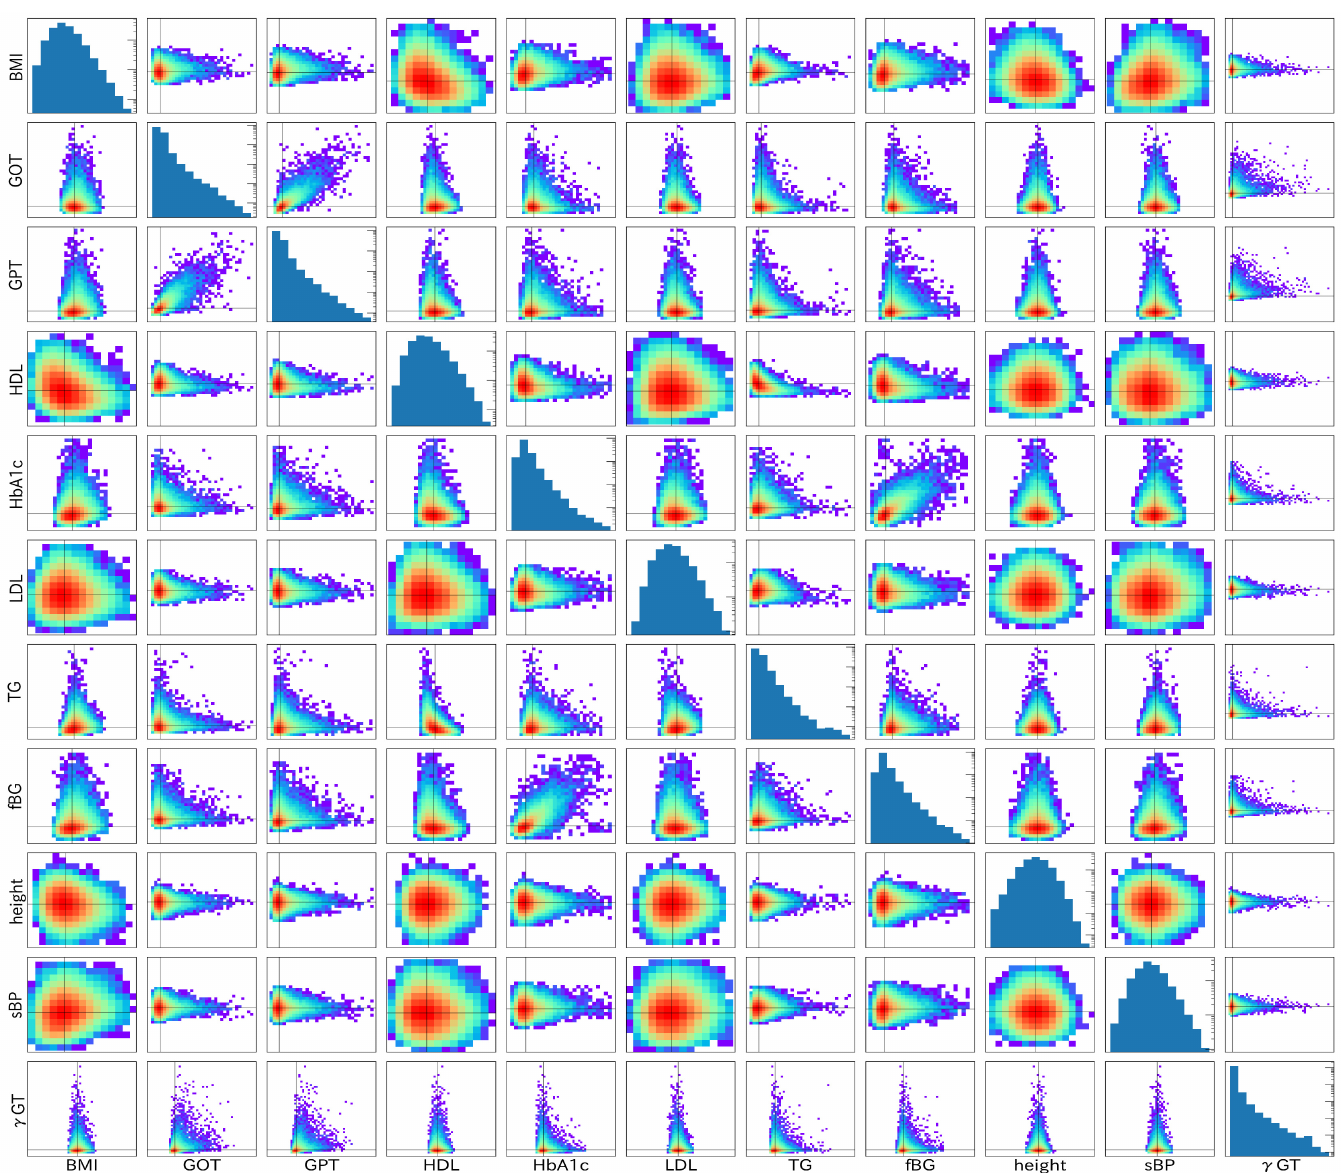
Fig 1. Basic correlations among health indices and distributions for individual indices are shown for women in their 70s. Basic correlations among health indices are presented on a log-scale density plot in non-diagonal slots. Distributions of health indices are presented in the log-scale histogram in the diagonal slots.